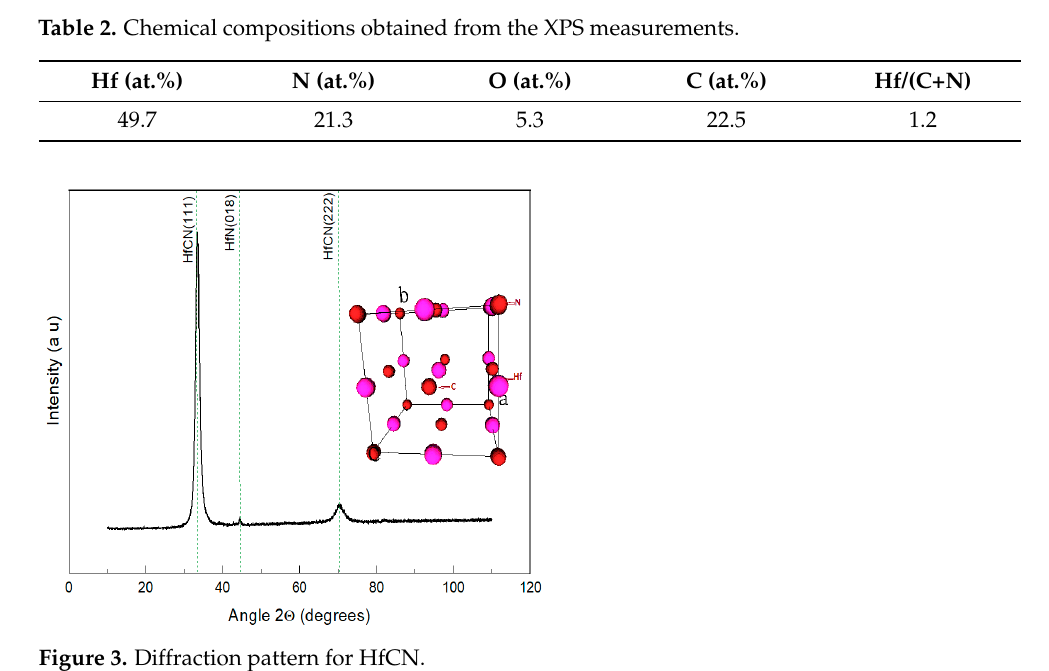
Figure 2. High resolution XPS spectra for the fi lm grown at a bias voltage of − 150 volts: ( a ) Hf signal ( b ) C1s signal, ( c ) N1s signal. Table 2. Chemical compositions obtained from the XPS measurements. Hf (at.%)